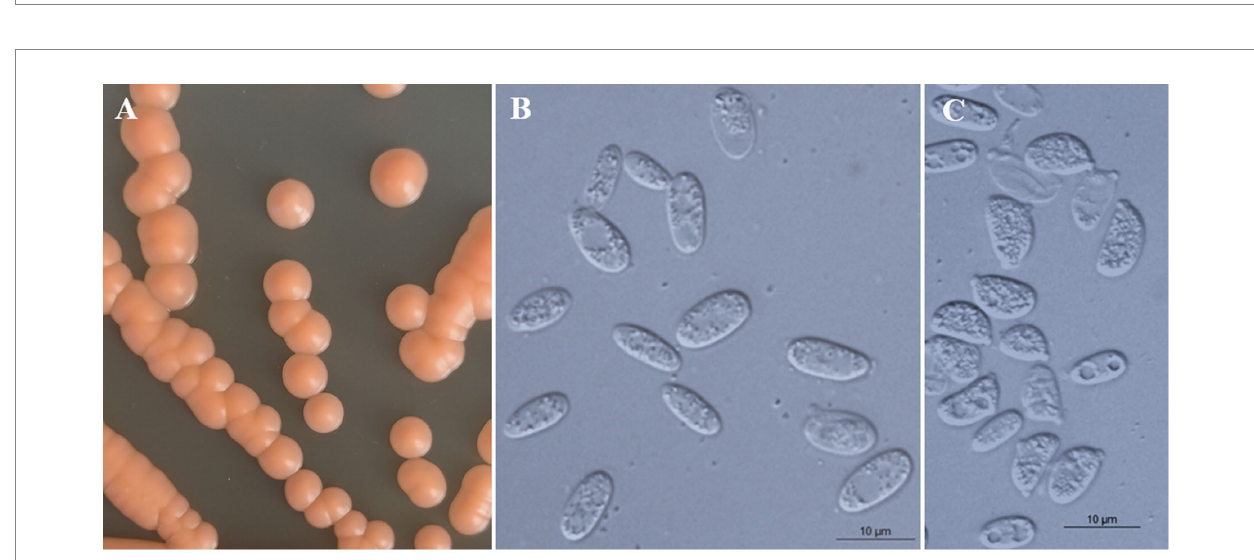
FIGURE 3 Morphological characteristics of Bannoa ellipsoidea sp. nov. (GDMCC 2.279, holotype). (A) Colony morphology on YM agar after growth for 7 d at 25 ° C. (B) Budding cells after growth for 7 d in YM broth at 25 ° C. (C) Ballistoconidia on CM agar after growth for 7 d at 25 ° C. Scale bars = 10 μ